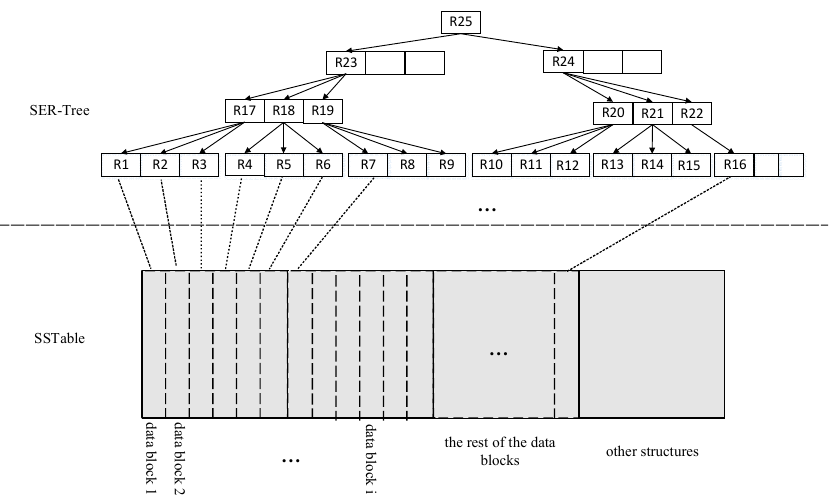
Figure 5. SER-tree index structure on an SSTable.